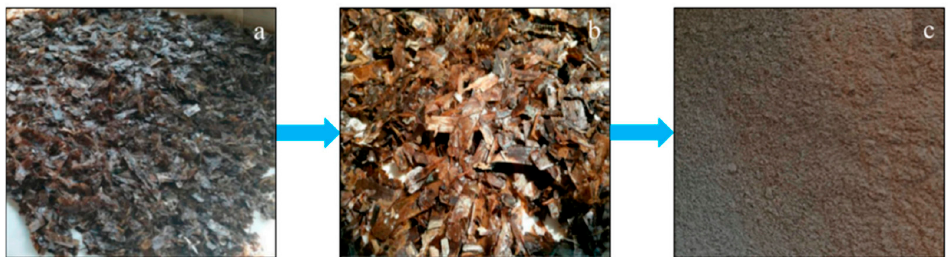
Figure 4. Posidonia oceanica leaves (POL), ( a ): before washing, ( b ) after washing, ( c ) after being chopped [71]. Distributed under the terms and conditions of the Creative Commons Attribution (CC BY) license